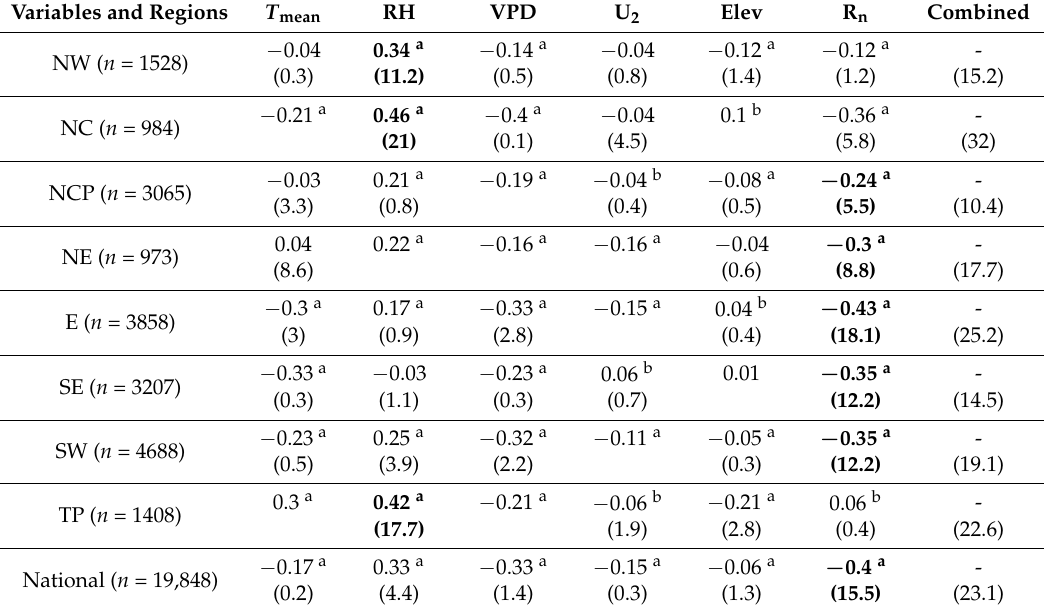
Table 4. Pearson’s correlation between the conversion coefficients (K p ) and various climate factors, and the independent explanatory powers of each variable based on K p variation derived from the stepwise multiple linear regressions (%, in parentheses). T mean is the mean air temperature, RH is the relative humidity, VPD is the vapor pressure deficit, U 2 is the wind speed at a height of 2 m, Elev is the elevation, and R n is the net radiation. The dominant factors are highlighted in